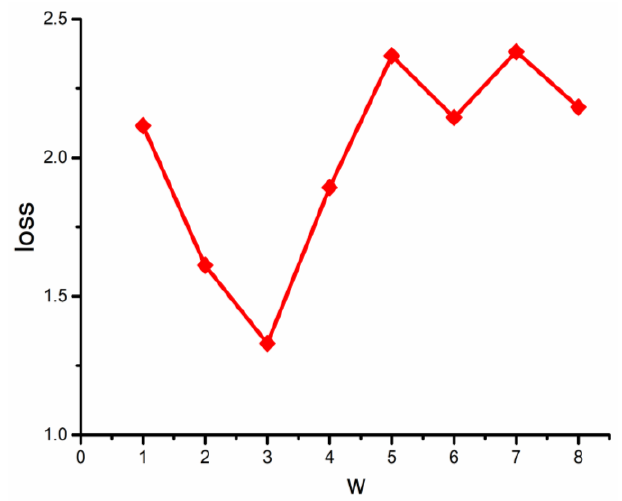
Figure 6. Linear graph of loss variation.